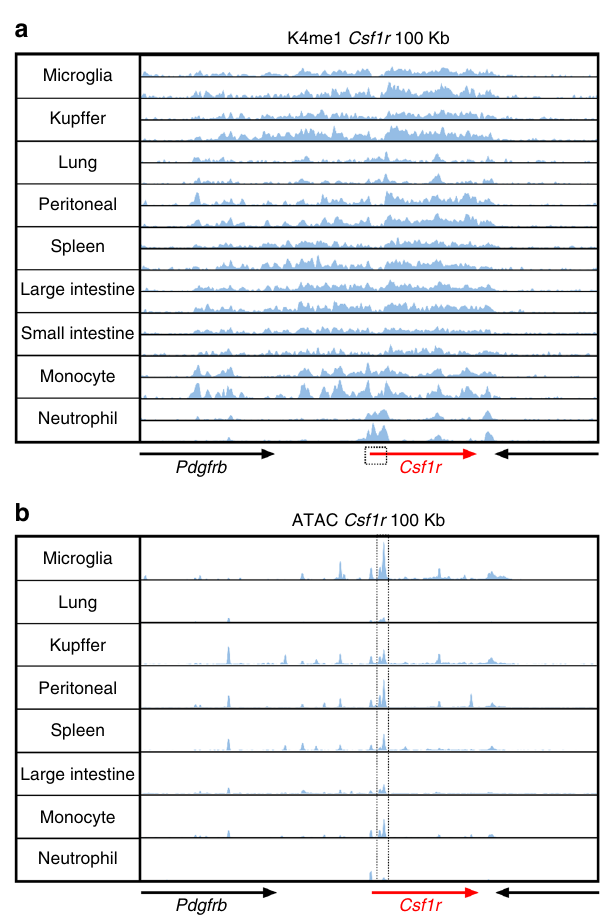
Fig. 9 Chromatin landscape of the mouse Csf1r locus. ChIP-seq and ATAC- seq data for the 100 kb window surrounding mouse Csf1r for each of the isolated myeloid cell populations shown was extracted from the primary data generated in Lavin et al. 66 . a ChIP-seq data showing the location of poised enhancers (H3K4me1). The boxed area indicates the 3.5 kb promoter region used in the production of Csf1r reporter genes. b ATAC- seq data showing the locations of open chromatin. The dotted lines surround the double peak in the second intron; the more prominent